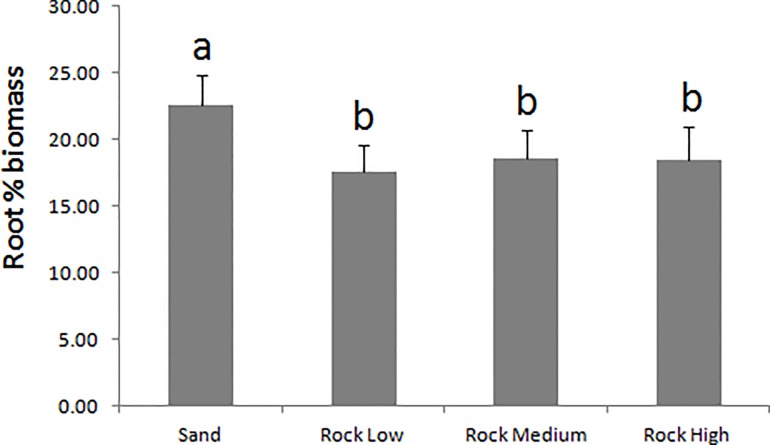
Effect of the Substrate on the root % biomass in P. oceanica seedlings.Letters above standard error bars indicate significant differences between treatment levels.